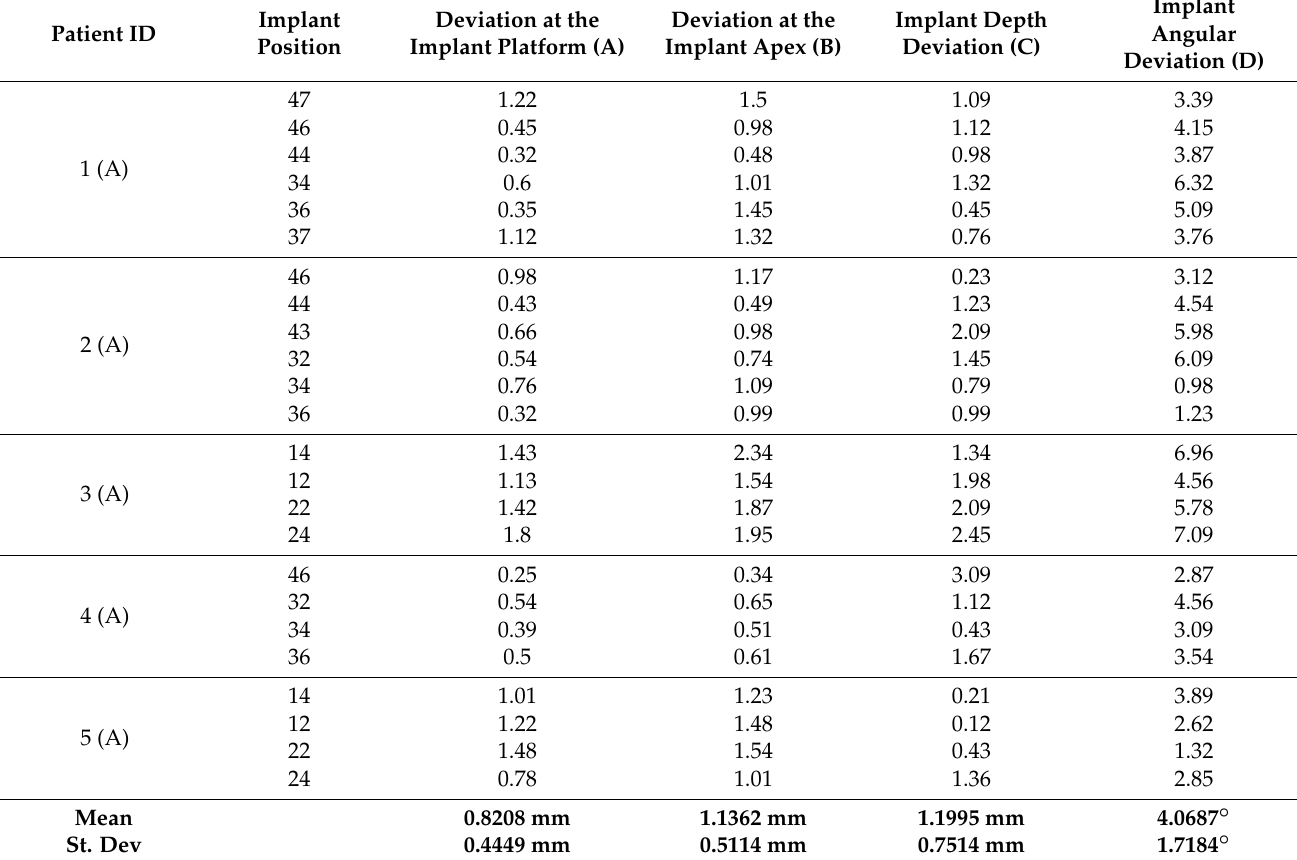
Table 2. Deviation measured in patients of group